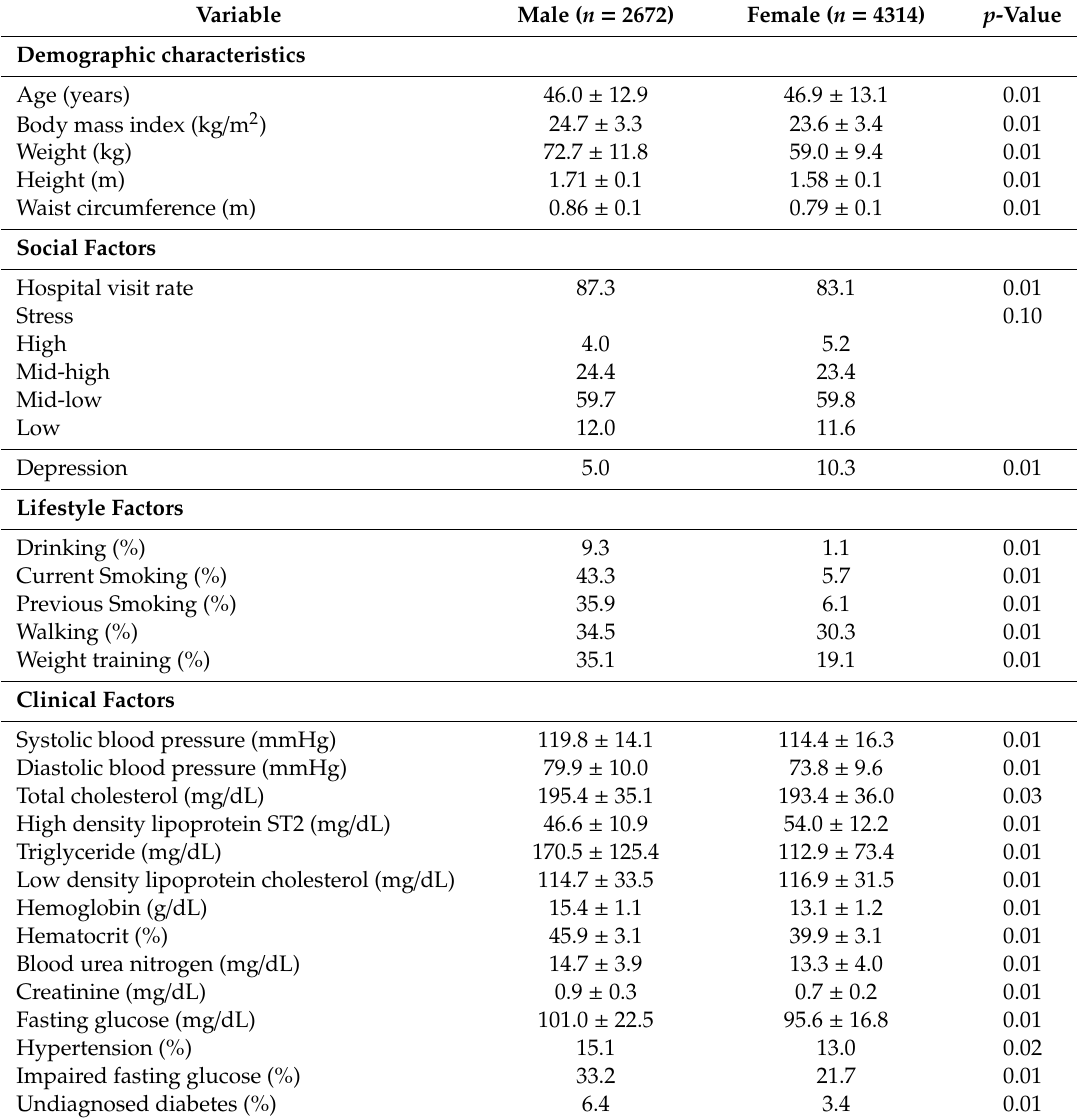
Table A3. Baseline characteristics of male and female participants with family history of diabetes (FHD).